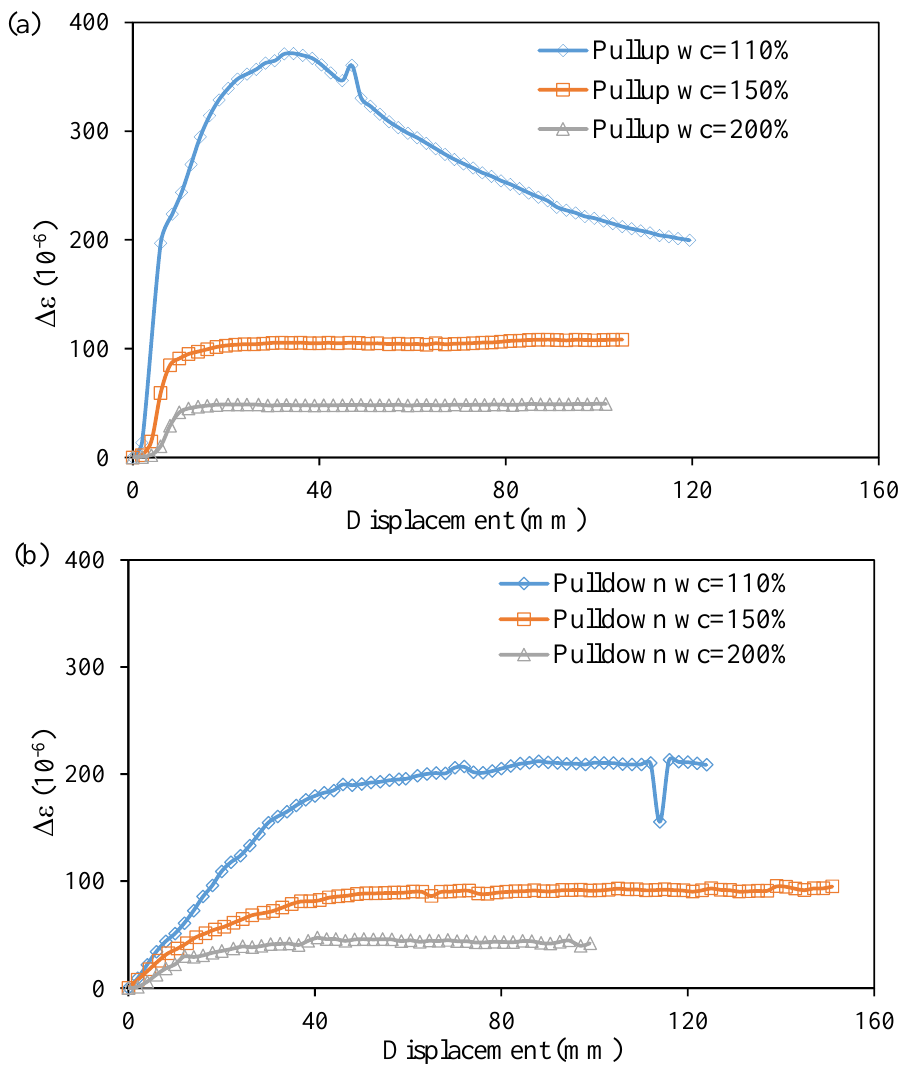
Figure 5. Measured strain change by the OFDR coin sensor: ( a ) pullup tests; and ( b ) pulldown tests.